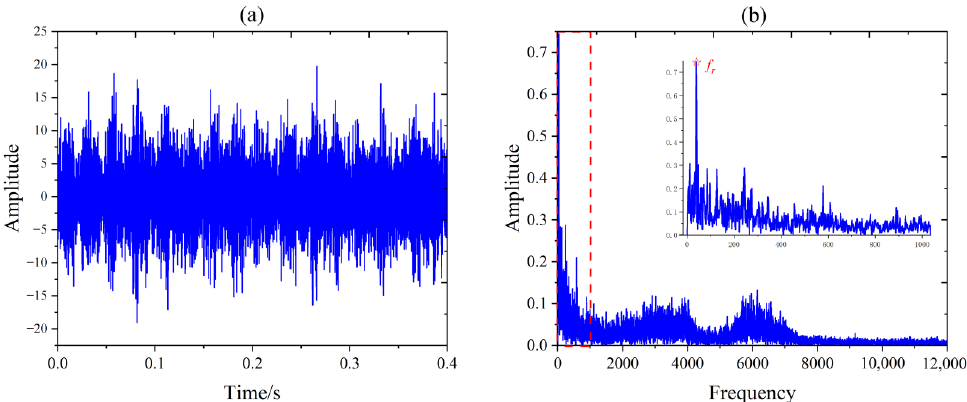
interval of T is set as [120, 140], [197, 217], [299, 319], respectively. The MDMVO algo- rithm is used to optimize the parameters of MCKD.